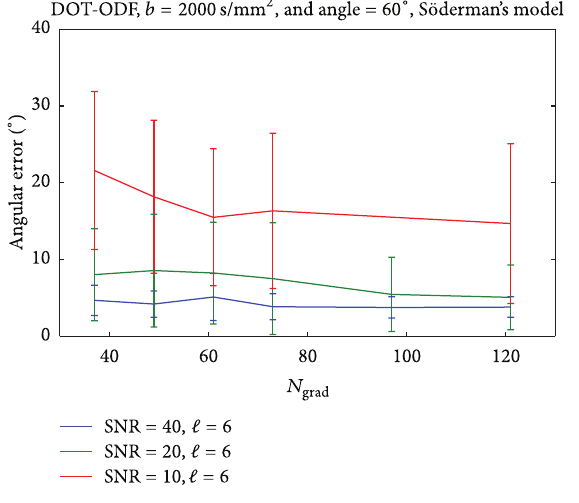
Figure 10: Influence of the SNR on the accuracy of the analytical DOT-ODF imaging for angle of 60 ∘